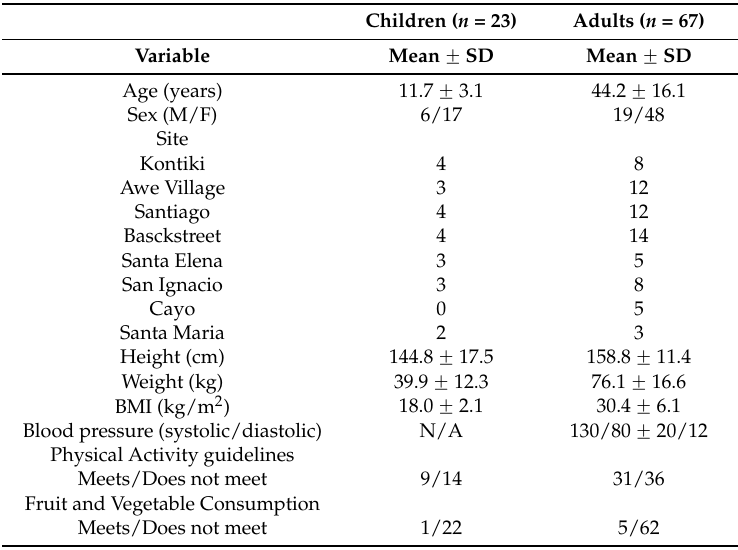
Table 1. Children and adults’ demographic